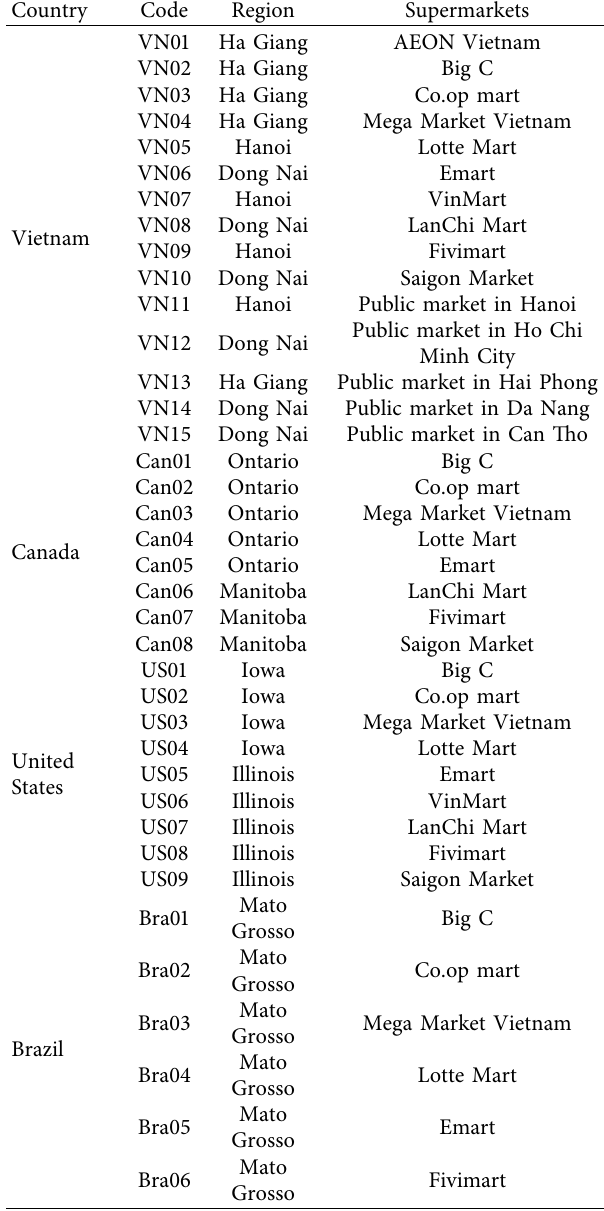
Table 1: Summary of soybean samples analyses throughout the study.